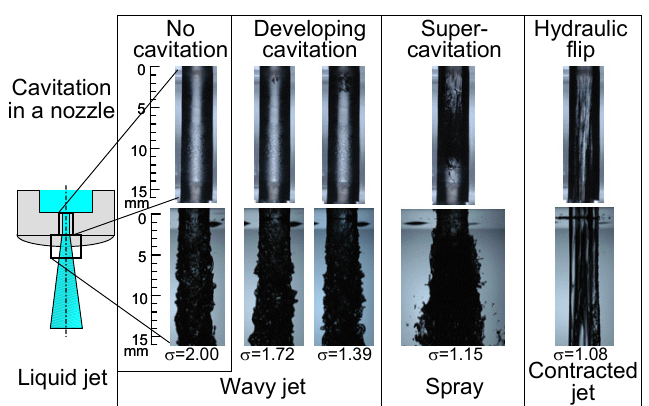
Fig. 4 Cavitation and liquid jet in a cylindrical nozzle ( D N = 4 mm, C u = 64, L / D N = 4)